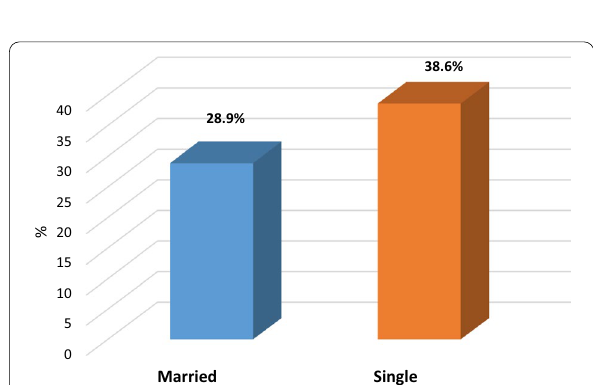
Fig. 3 Marital status of the patients as predictor for moderate and severe insomnia